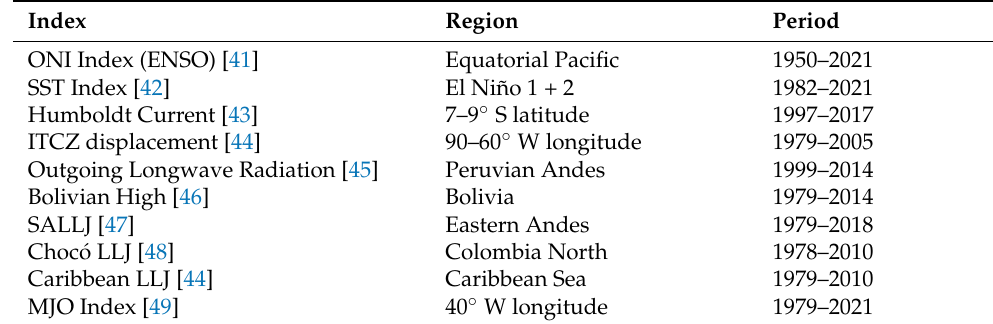
Table 2. Indexes and description of the main climate pattern indexes used in the study comparison. Region of the data and source are also